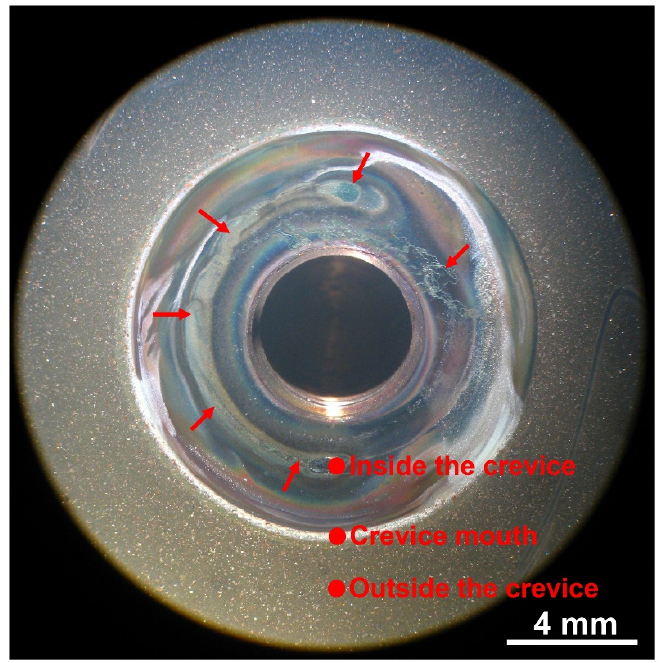
Figure 2. Surface appearance of the crevice sample exposed to 290 °C NaCl solution.